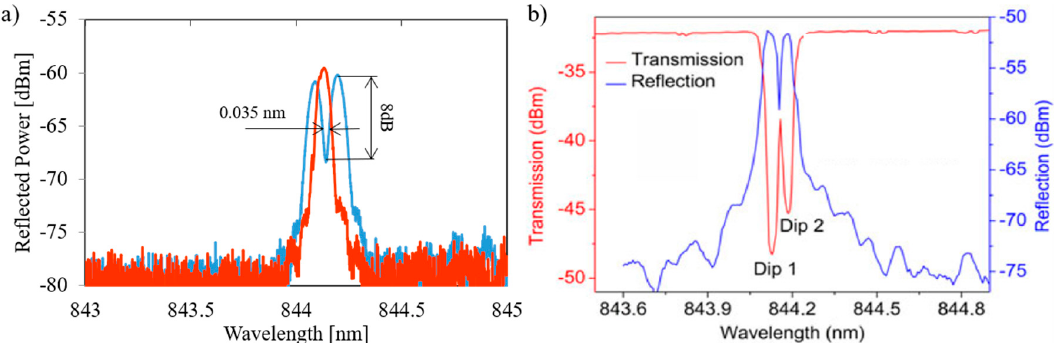
Figure 6. PS-FBG fabrication by 248 nm irradiation: ( a ) Moiré overlapping method (image adapted from [106]); ( b ) a narrow blocking in the center (image adapted from [107]).